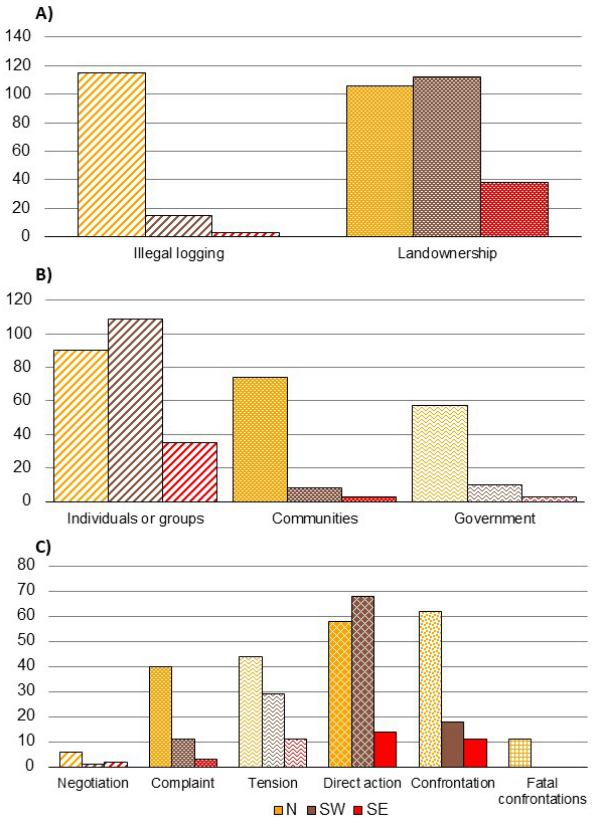
Fig. 4 . Number of conflicts per subregion grouped by: (A) causes, (B) actors, and (C)